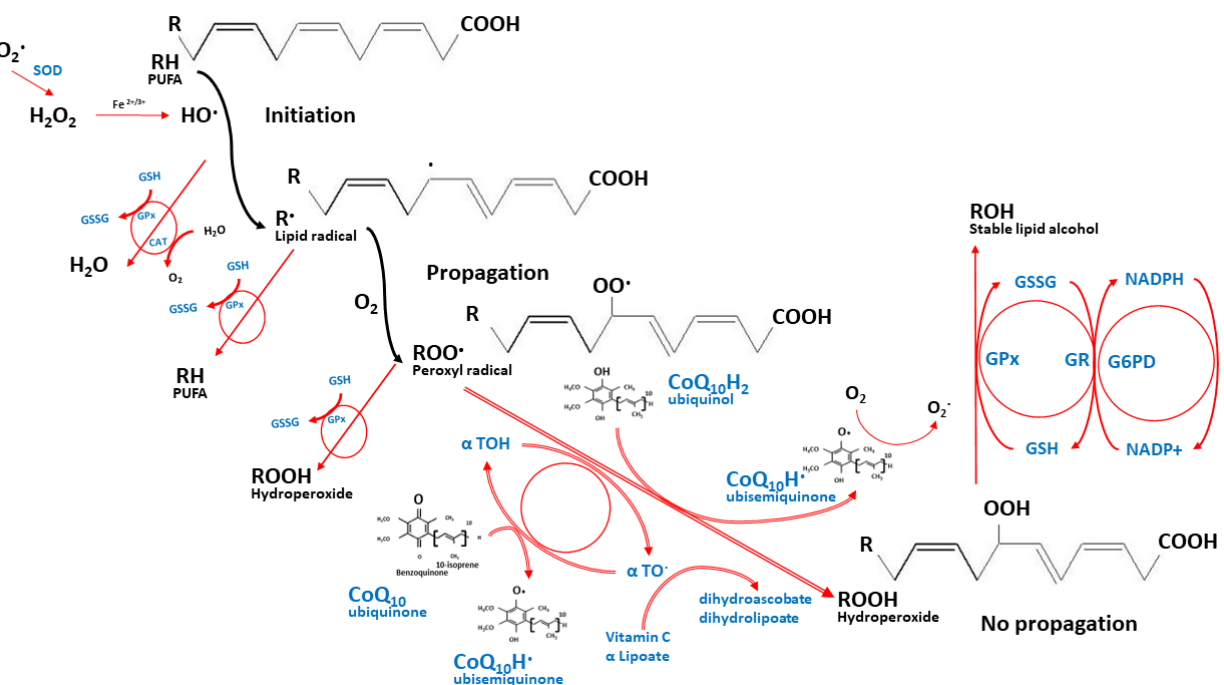
Figure 2. The integrated antioxidant defenses against lipid peroxidation. The nutrient network halts the propagation of lipid peroxyl radicals while their redox interactions maintain their reduction states. These nutrients include coenzyme Q 10 , α tocopherol, vitamin C, α lipoic acid, glutathione, and the micronutrients that support the activities of antioxidant enzymes such as selenium, manga- nese, copper, and zinc (not shown in the figure). O 2 • — superoxide anion radical, H 2 O 2 — hydrogen